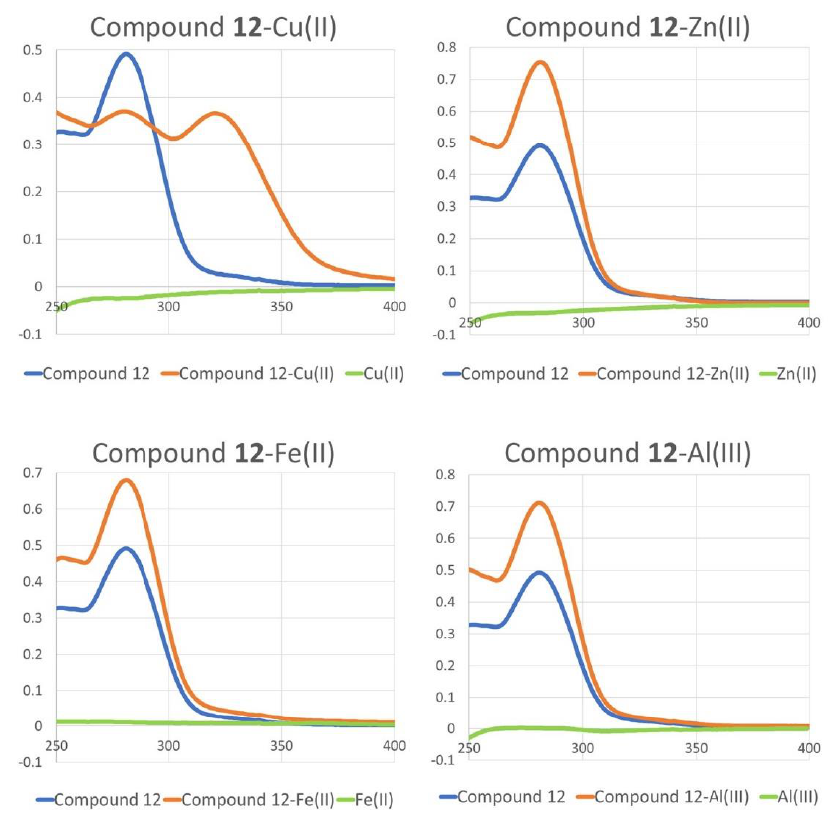
Figure 3. Absorbance spectra of compound 12 in the absence and in the presence of copper ion, iron ion, zinc ion, and aluminum ion (10 µ M) and spectra of copper, iron, zinc aluminum ions, determined by UV-Visible spectroscopy with water/DMSO (90:10) as the solvent. Hence, although 12 , the only acetylated nucleoside, did not show promising cholin- esterase inhibition, it became the first nucleoside-based molecule with metal chelating properties and, therefore, became a starting point for the investigation of structural mod- ifications that could lead to the desired dual-target compounds against AD. In order to understand which structural alterations could be carried out to achieve our goal, computational studies were performed. Molecular electrostatic potential maps, in which the red and blue hues represent negatively and positively charged regions, re- spectively, and green tones depict neutral regions, were generated for compounds 5 - 7 , 9 , and 12 . In all cases, a significant electron density in the amide group of the purine base was found, and the benzyl units were found to be almost neutral. Moreover, compound 7 , exhibiting N 7 purine ligation, also exhibits high electron density between atoms N3 and N9, and compound 12 shows some negative density in the acetyl groups. Hereinafter, the generated maps for compounds 7 and 12 are disclosed (Figure 4), the remaining being found in the Supplementary Materials (Figures S48 – S50).